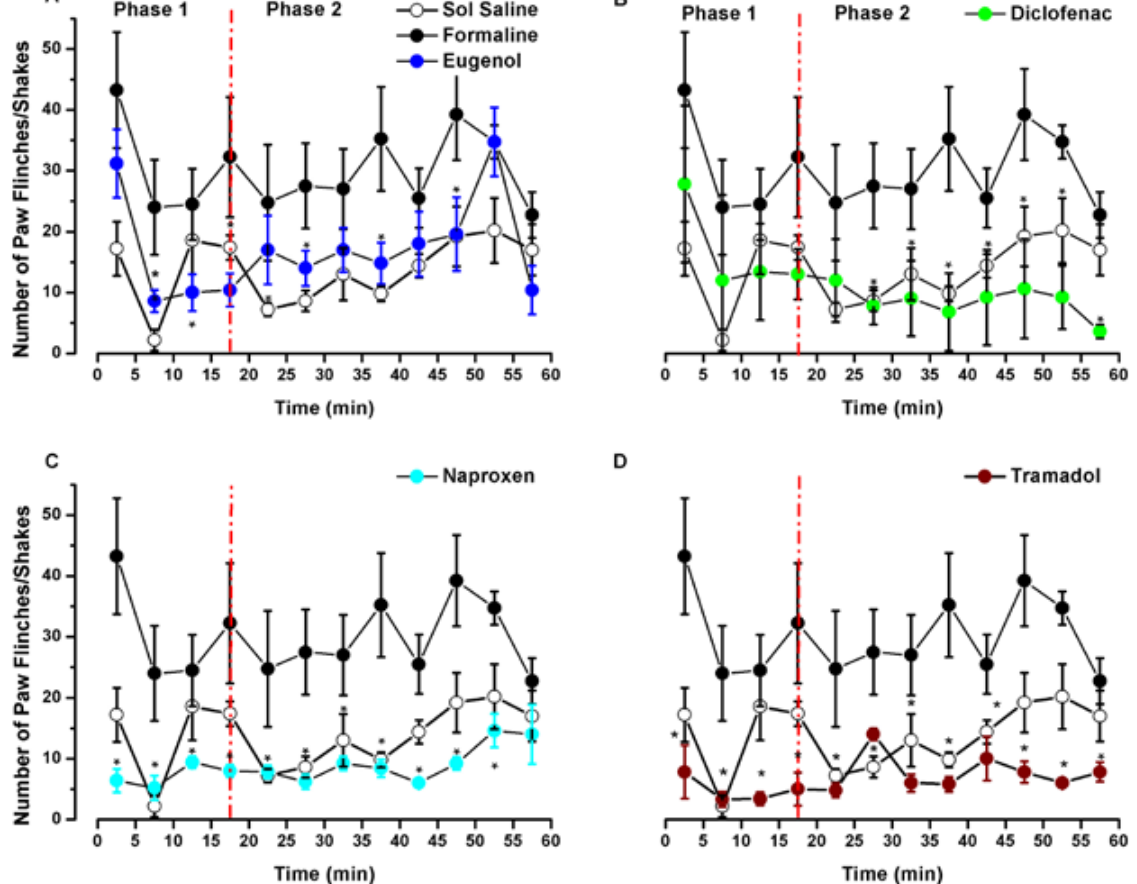
FIGURE 1 - Time course of the formalin test to 5%, panel (a) represents the effect of Eugenol to 1,400 µg/kg, panel (b) is that of Diclofenac to 250 µg/kg, panel (c) Naproxen to 400 µg/kg, and panel (d) Tramadol to 500 µg/kg on intraplantar administration. The data represent the Ẋ ± SEM of an n = 5, while (*) represents a statistically significant difference vs. formalin at 5% (p